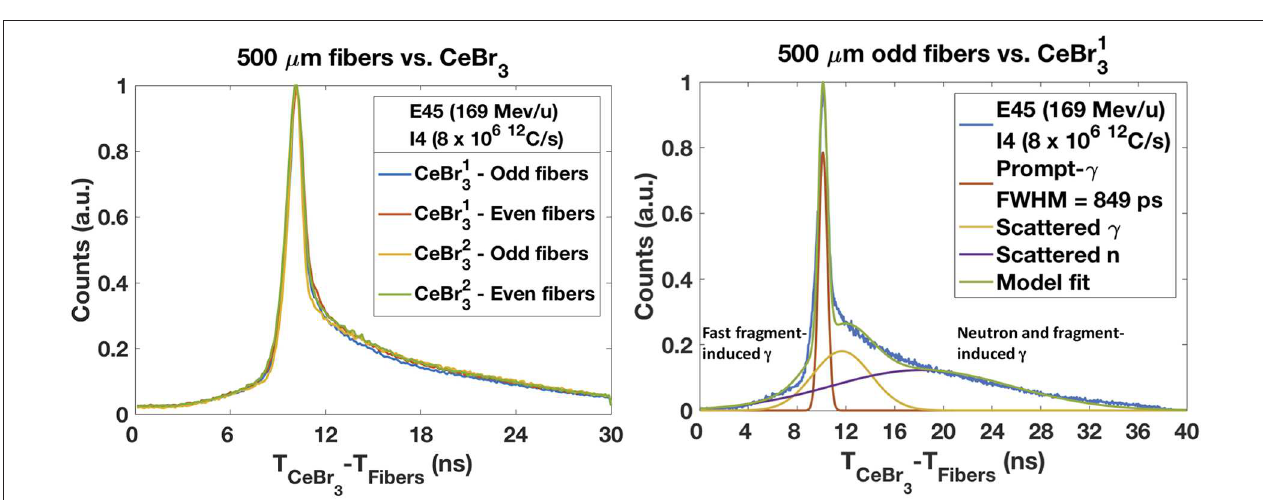
FIGURE 7 | Time resolution of the PGS system. (Left) The time difference between the arrival from prompt-gamma to the two CeBr 3 detectors and the arrival from carbon ions to the odd and even scintillating fibers. (Right) The time difference between the CeBr 1 3 and the odd fibers shows a prompt component (red) with 0.85 ns FWHM. A delayed component resulting from neutron and fragment induced γ -rays is observed and may be removed by TOF cuts. A fast component resulting from fragment induced γ -rays scattered in the nozzle is also visible.